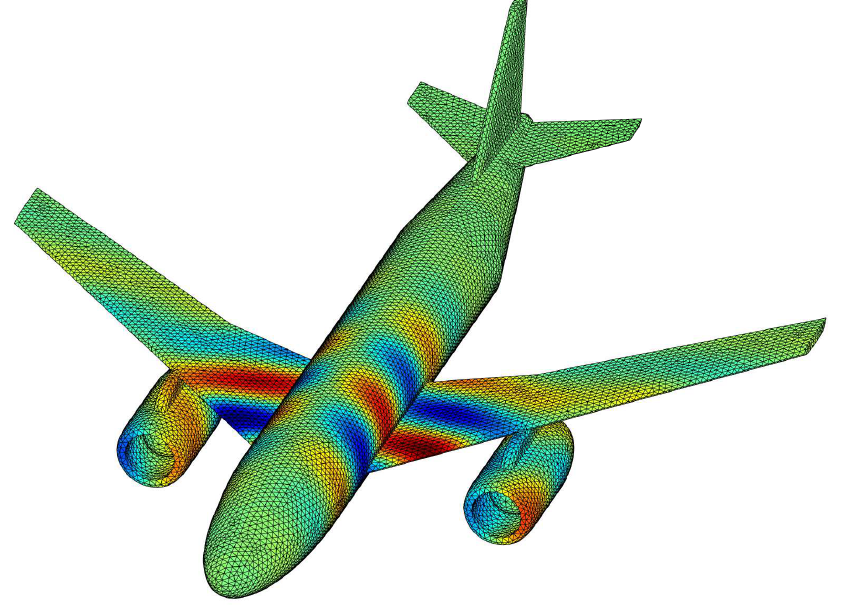
Figure 8. Airplane excited by a GMP. Snapshot of the electric potential wave propagation obtained from the unstructured MOT–PEEC code for equivalent surface